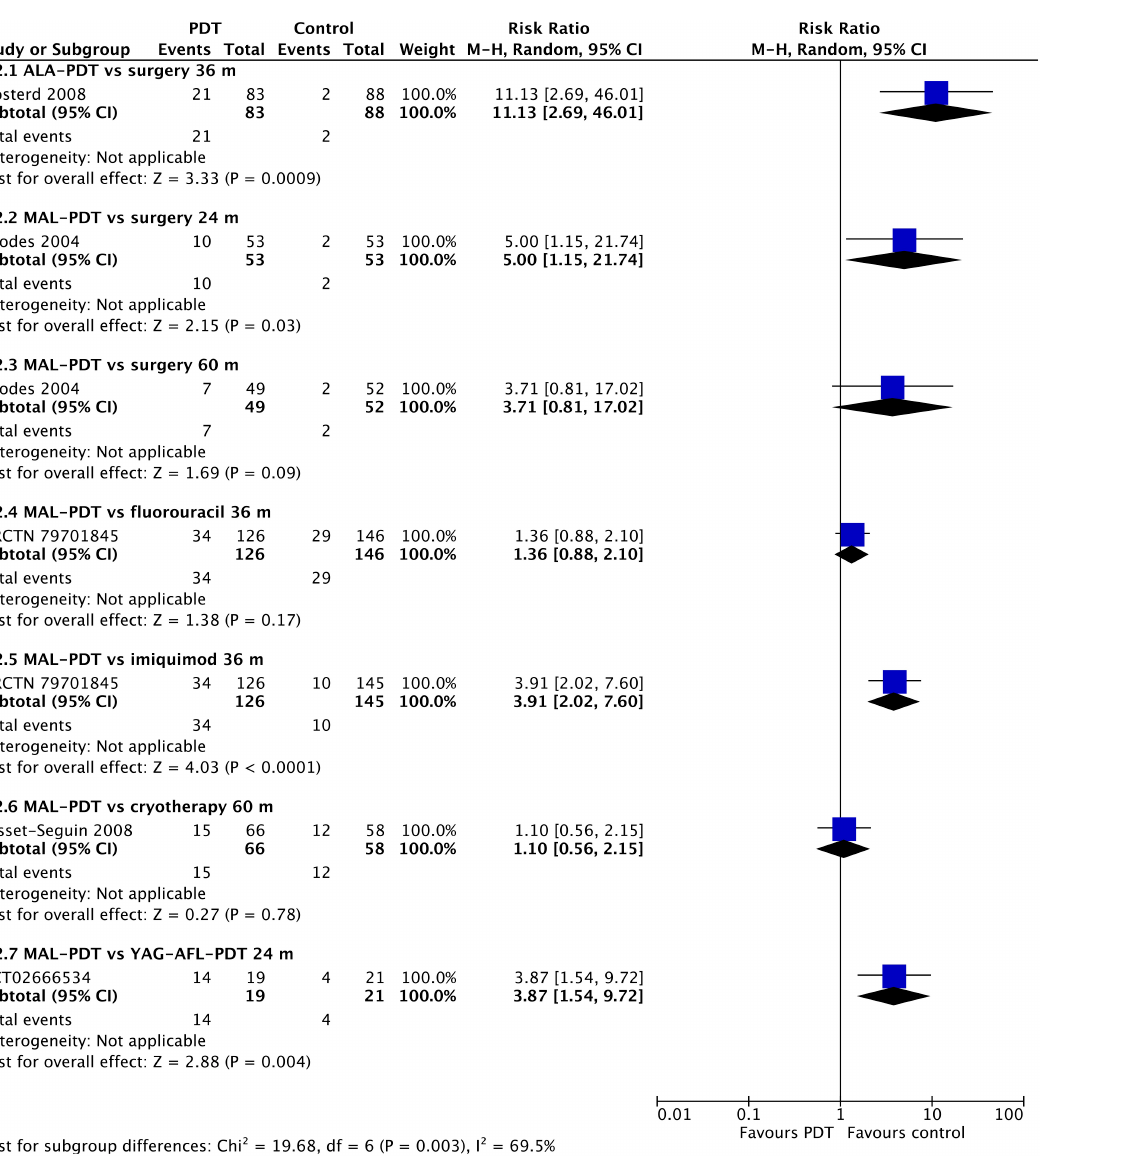
FIGURE5 Meta-analysis of the risk of recurrence at 24 to 60 months post-treatment by comparator. Data are risk ratios with 95% confidence